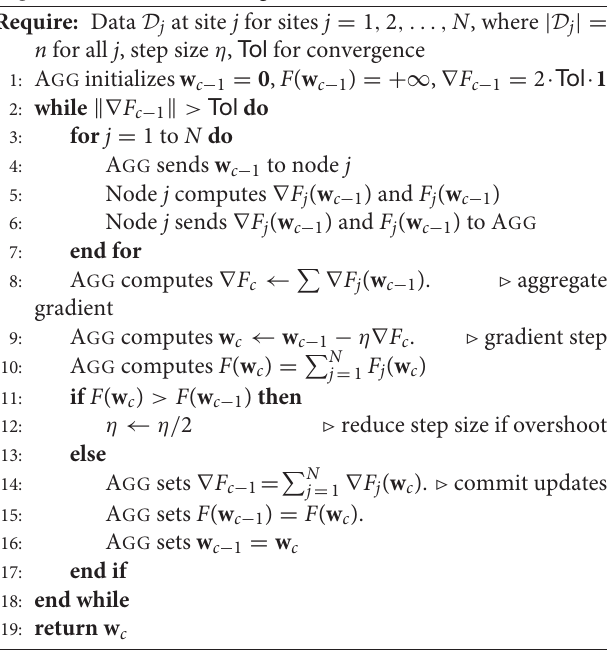
Algorithm 2 Decentralized gradient